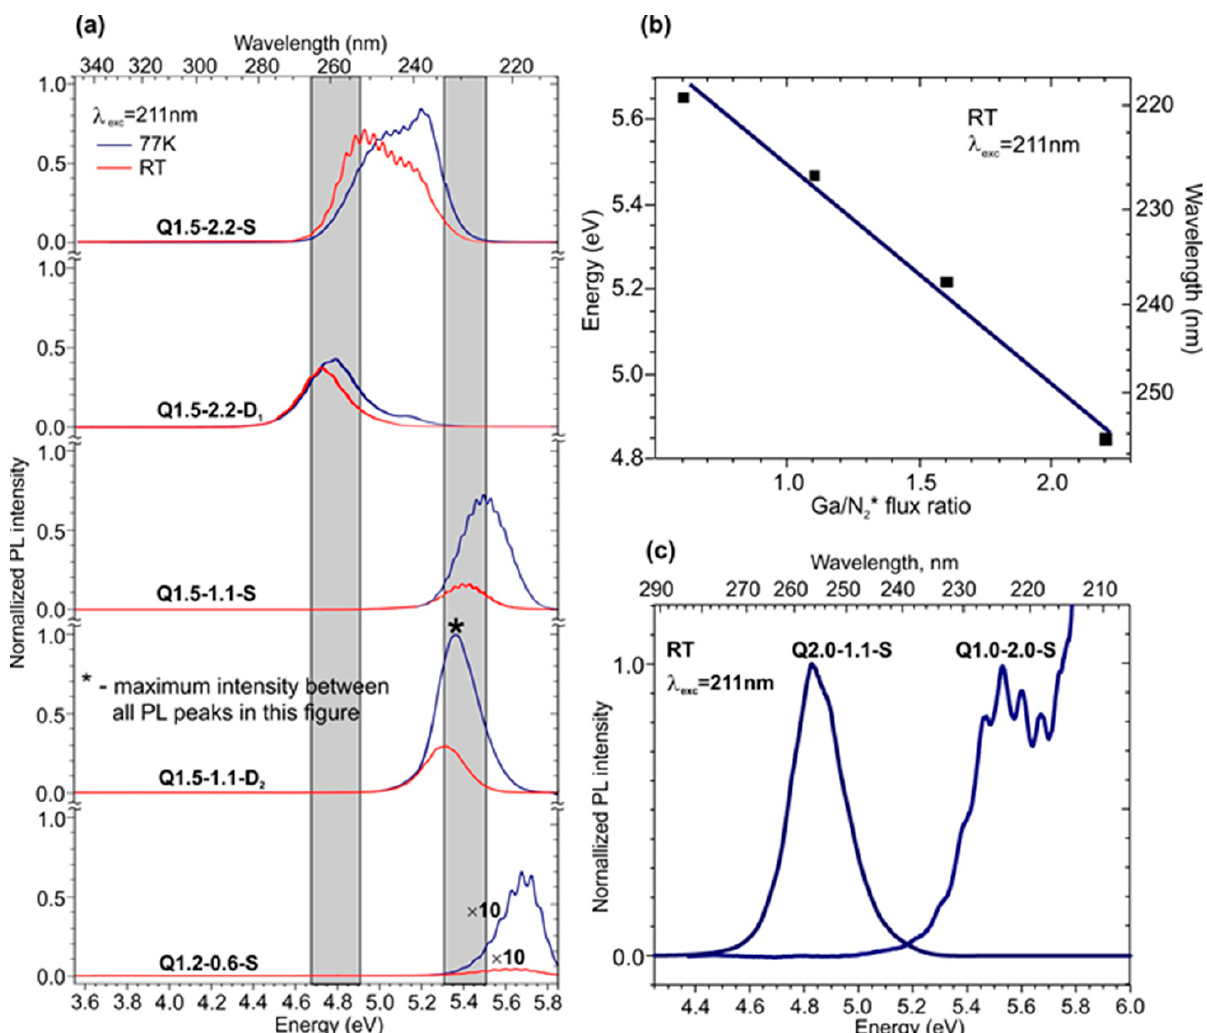
Figure 8. ( a ) PL spectra measured at RT (red) and 77 K (blue) in 400 × {GaN m /AlN 16 } ( m = 1.2, 1.5) structures grown under various Ga/N 2 * flux ratios on different AlN templates. The right and left, gray areas show the energy positions of the PL peaks in MQW structures with integer QW thicknesses of 1 and 2 ML. ( b ) Dependence of the spectral position of the PL peak (RT) on the Ga/N 2 * flux ratio used to grow 400 × {GaN 1.5 /AlN 16 } structures on the S-type template. ( c ) PL spectra measured at RT in the 400 × {GaN m /AlN 16 } MQW structures with various nominal integer thicknesses of the wells ( m = 1 and 2) and grown at a different Ga/N 2 * ratio on the S-type template.